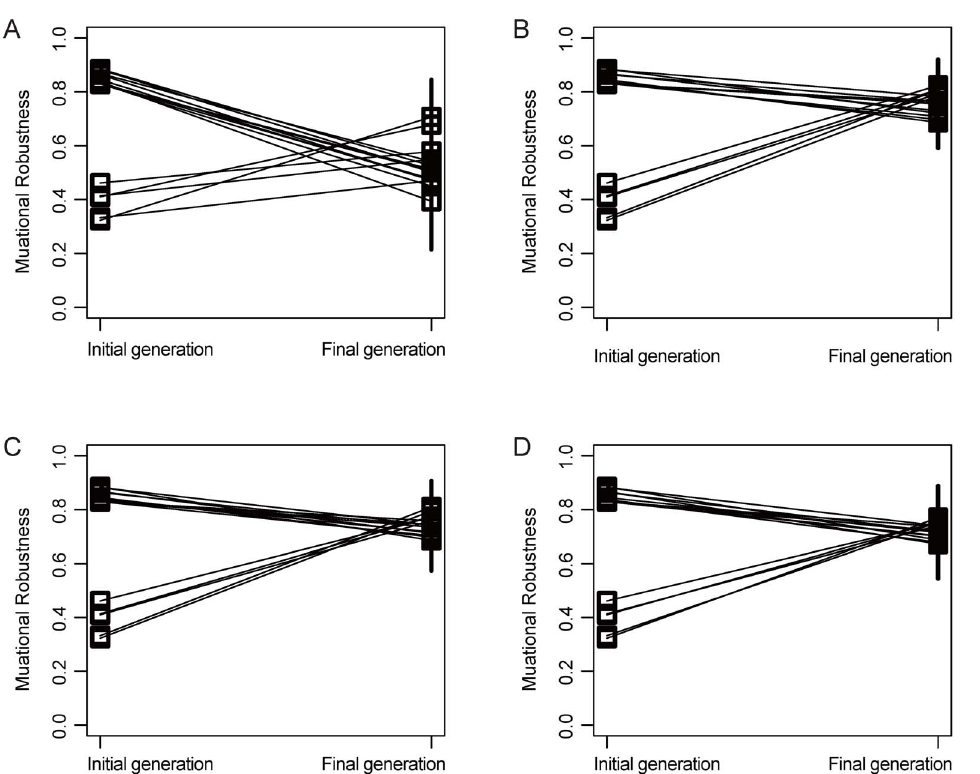
Fig. 2. Convergent evolution of mutational robustness. The dots represent the actual mutational robustness levels of a group of GRNs having identical initial d 5 0.1. The mutational robustness levels at the initial and final generation are linked by solid lines. The population size is 100, and mutation rates are A) 0.001, B) 0.05, C) 0.1 and D)